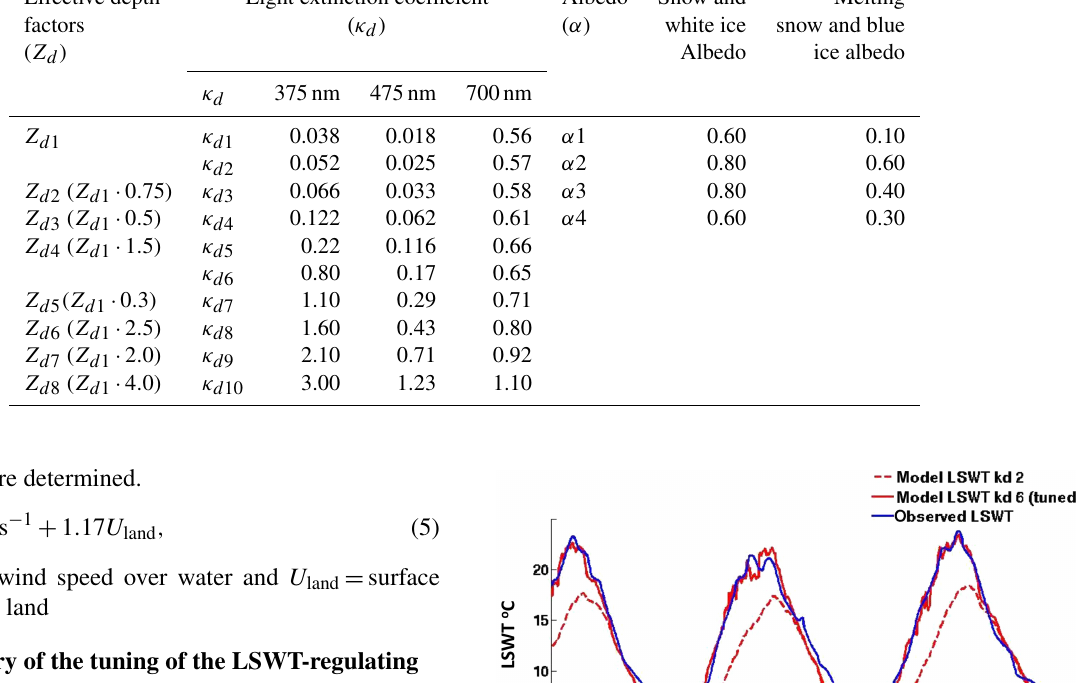
Table 2. Effective depth factors ( Z d ) , light extinction coefficient values ( κ d ) and snow and ice albedo values ( α) used in tuning study; 80 possible combinations used for tuning of seasonally ice-covered lakes ( Z d 1 : Z d 4 × κ d 1 : κ d 5 × α 1: α 4). The modified tuning for the 25 shallow seasonally ice-covered lakes utilised greater depth factors; Z d 6 : Z d 8 and two higher light extinction coefficient values, κ d 6 and κ d 7 ; 60 possible combinations used for tuning of non-ice-covered lakes ( Z d 1 : Z d 6 × κ d 1 : κ d 10 ) . The spectre for the 10 κ d values are divided (in fractions of 0.18, 0.54, 0.28) into bands represented by three wavelengths: 375, 475 and 700nm respectively. Effective depth Light extinction coefficient Albedo Snow and Melting factors ( κ d ) ( α) white ice snow and blue ( Z d ) Albedo ice albedo